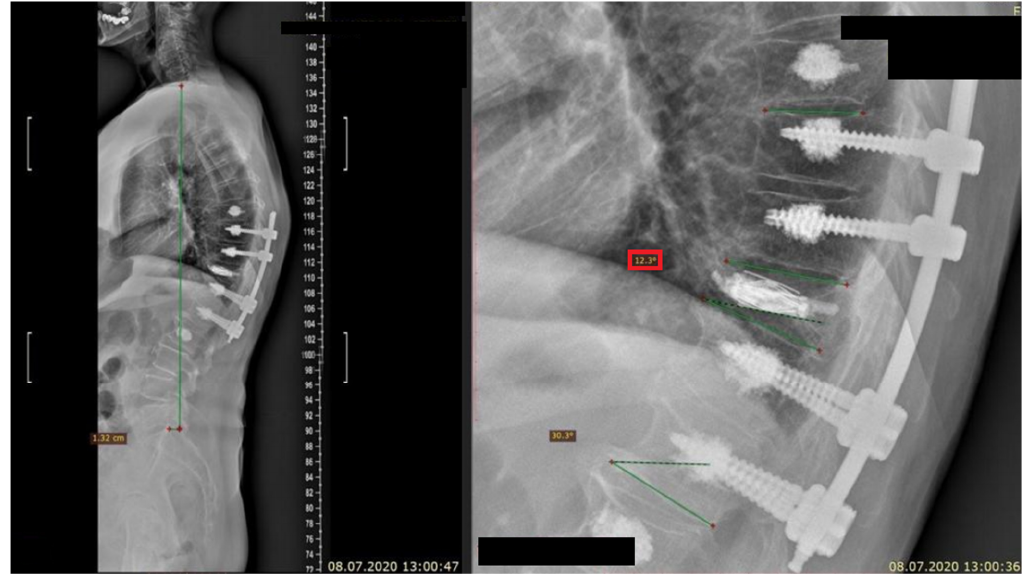
Figure 3. Imagining of a vertebral body height restoration achieved with an introduced surgical approach, consisting of SJ system, accomplished by PVP and minimally invasive percutaneous transpedicular fixation using bone-cement screw augmentation.